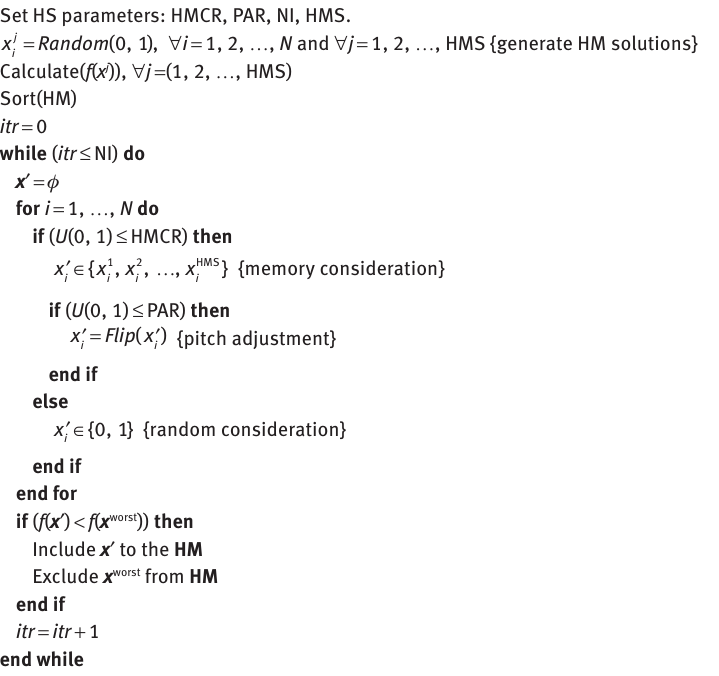
Algorithm 1: Binary HS Algorithm